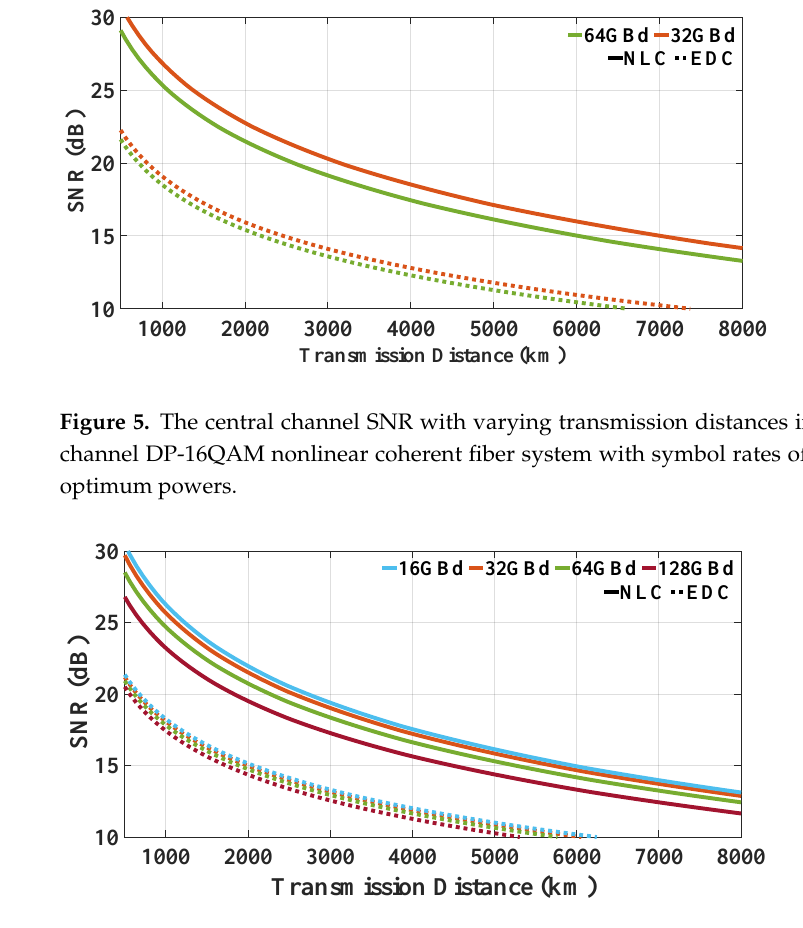
Figure 6. The central channel SNR with varying transmission distances in the wideband Nyquist- spaced DP-16QAM nonlinear coherent fiber system with transmission rates of 16, 32, 64, and 128 GBd at their optimum powers, where transmission bandwidth is fixed at 4.5